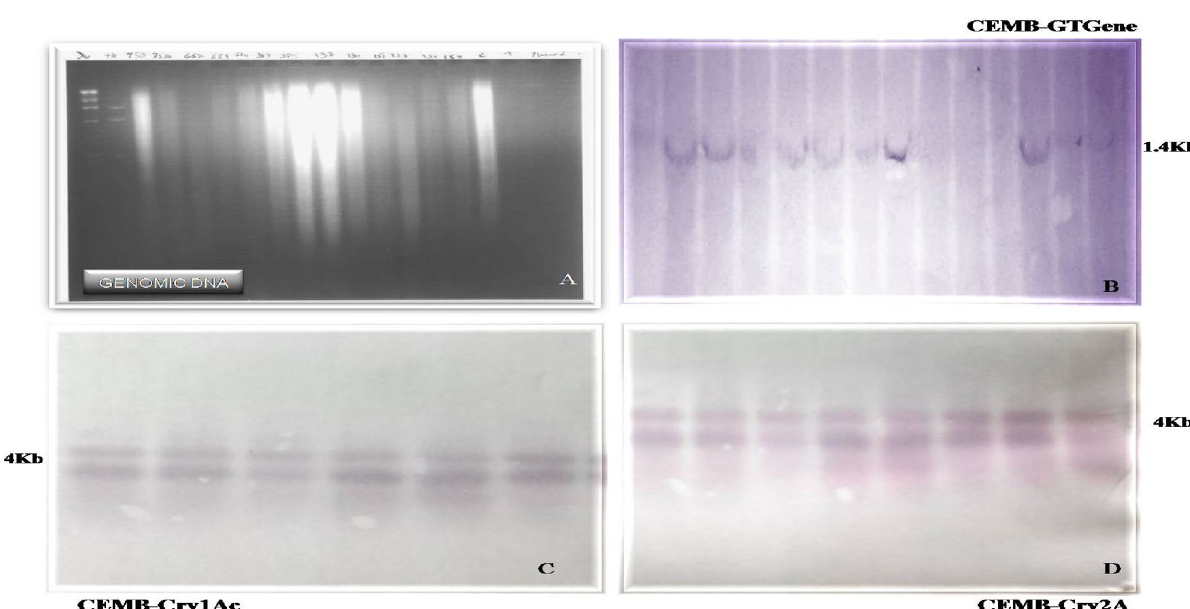
Figure 16. Southern Blot analysis of the transgenic sugarcane plants (CEMB- Cry 1Ac, CEMB- Cry 2A and CEMB-GTGene) in V 1 -generation. ( A ) Denaturing genomic DNA. ( B ) Southern DNA hybridization of transgenic sugarcane plants with CEMB-GTGene probe. (C ) Southern DNA hybridization of transgenic sugarcane plants with CEMB- Cry 1Ac probe. ( D ) Southern DNA hybridization of transgenic sugarcane plants with CEMB- Cry 2A